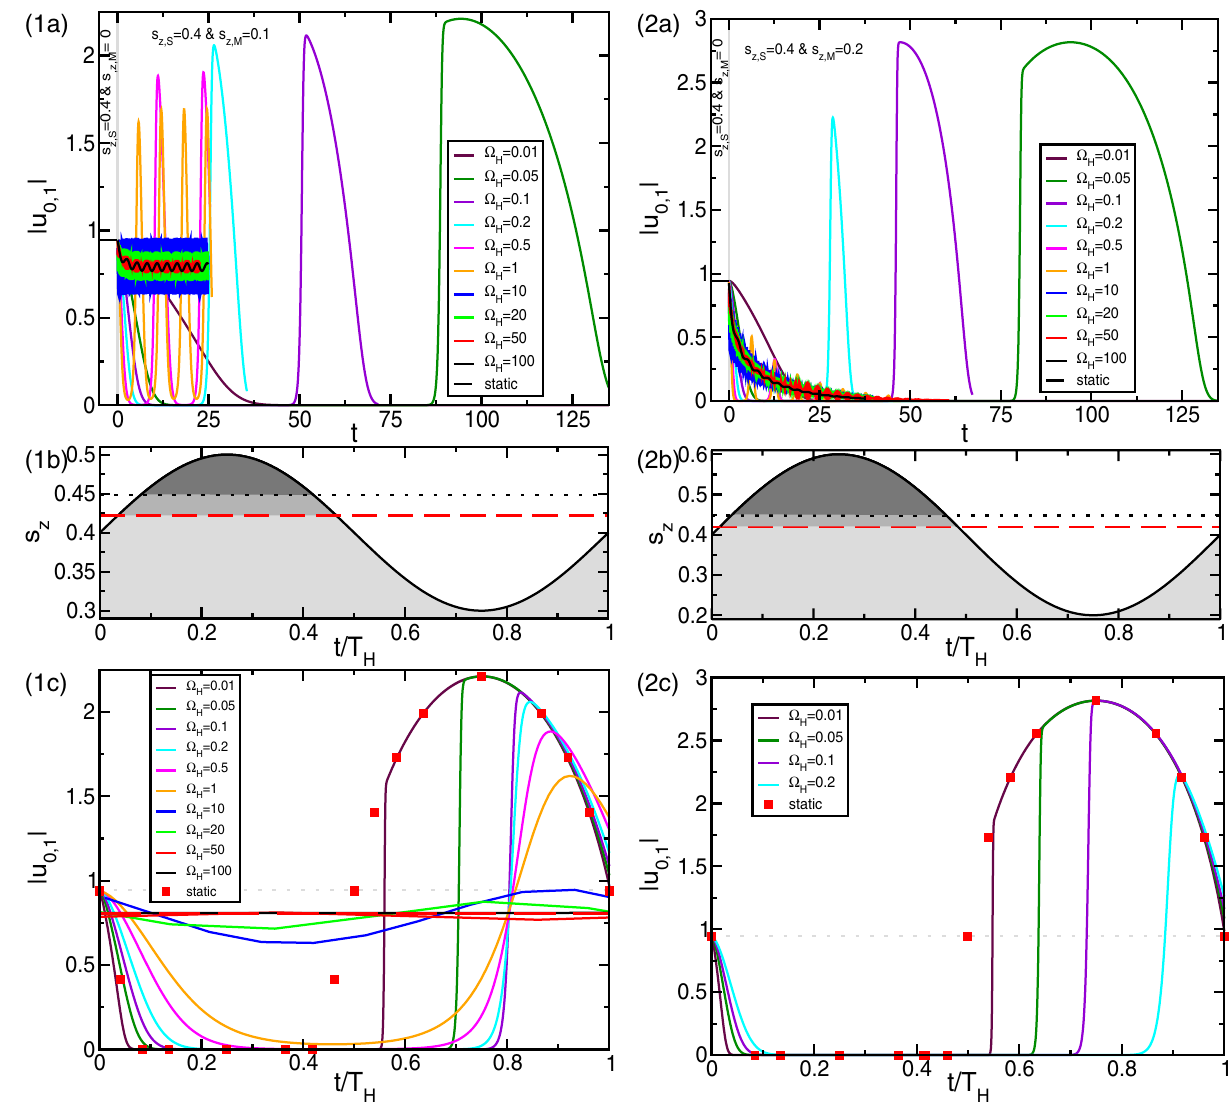
1 t/T H Figure 5. Non-linear system response around the instability. ( a ) Time evolution of the dominant mode amplitude | u 0,1 | as a function of time for different (cid:31) H as indicated and modulation amplitudes (1) s z , M = 0.1 and (2) s z , M = 0.2 , respectively (cf. trajectory III and IV in Fig. 1). Either of these modulation starts at s z t = 0 , before only a static field s z , S = 0.4 ( , M = 0.0 ) is present. For clarity/visibility mode amplitudes | u 0,1 | are only shown until t = 25 in case of (cid:31) H (cid:31) 0.5 ( 1a ). ( b ) Temporal oscillations of the control function s z ( t ) = s z s z t ) . The dotted black and dashed red lines mark the stationary ( s z s z , S + , M sin (� h , S = 0.4 , , M = 0.0 ) and high frequency limit oscillatory ( s z , S = 0.4 , s z , M = 0.1 ) bifurcation threshold, respectively. ( c ) as ( a ) but as a function of the reduced time t / T H . The red squares show the response to stationary magnetic field with magnetic field strength s z given by the actual value of s z ( t ) . The red dashed line in (1 c ) indicates the (time averaged) mode amplitudes for modulated driving ( (cid:31) H = 50, 100 almost falls on top of it). Note, that in (1) for modulated driving with (cid:31) H (cid:31) 0.27 the system remains supercritical. Other for (2) at which for modulated driving with (cid:31) H (cid:31) 0.27 the system remains subcritical. Further control parameter Re = 80 Walking the ridge of instability. In the following we will focus on an alternating magnetic field for such parame- ters that the system changes between subcritical and supercritical response over one period of driving. Consider for Re = 80 an alternating magnetic field with s z , S = 0.4 and s z , M = 0.1 or s z , M = 0.2 . While in the pure static case the system is supercritical (cf. point B in Figs. 1, 2), it becomes temporally subcritical for both considered modulation amplitudes. s z Small modulation amplitude ( , M = 0.1 ). The system becomes only slightly subcritical over one period. In the high frequencies limit the time averaged magnetic field (cid:31) s z ( t ) (cid:30) for modulated driving (dashed red line in Fig. 51c) corresponds to a static magnetic field with s z , S ≈ 0.423 (cf. inset in Fig. 2). With decreasing frequency (cid:31) H first the amplitude in the oscillating mode | u 0,1 | continuously increase before at (cid:31) H (cid:31) 0.5 it eventually becomes tem-